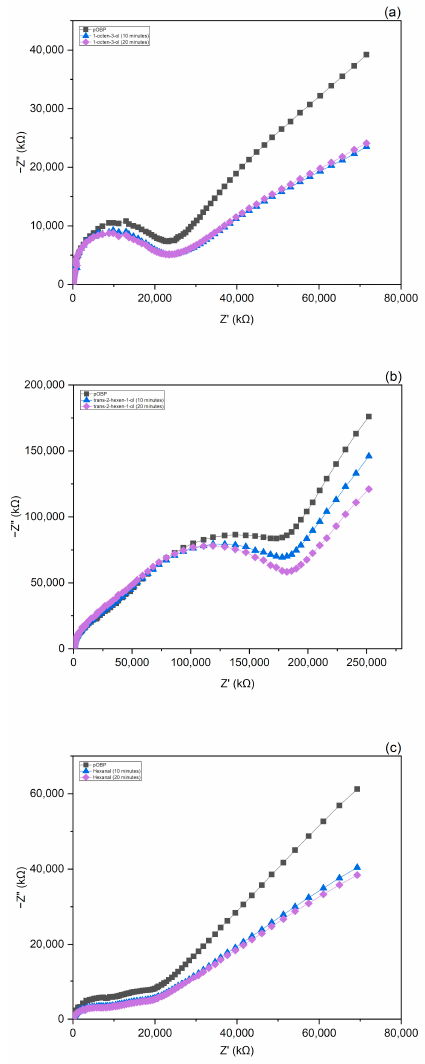
Figure 7. Impedance variations in air as a function of 1-octen-3-ol ( a ), trans-2-hexen-1-ol ( b ), and hexanal ( c ) concentrations.